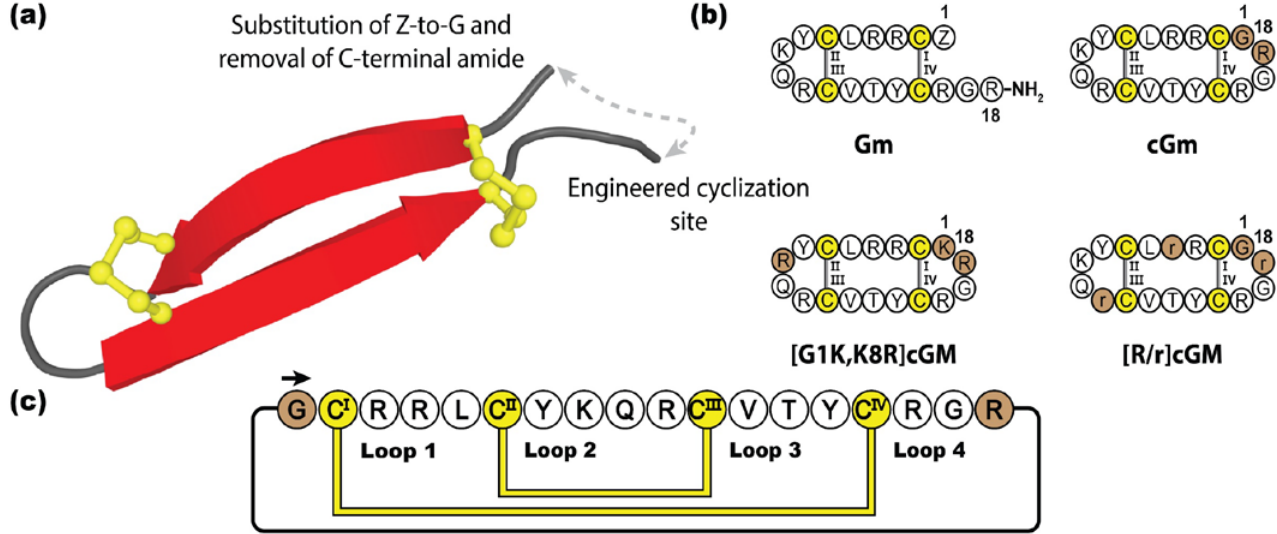
Figure 11. ( a ) Three-dimensional structure of Gm and its engineered cyclization site. ( b ) Peptide sequences of Gm and three engineered Gm variants. ( c ) Amino acid sequence of cGm, depicting disulfide bond connectivity and loop nomenclature. Cysteine residues are numbered and highlighted in yellow, with engineered cyclization sites and modifications indicated with brown shading.